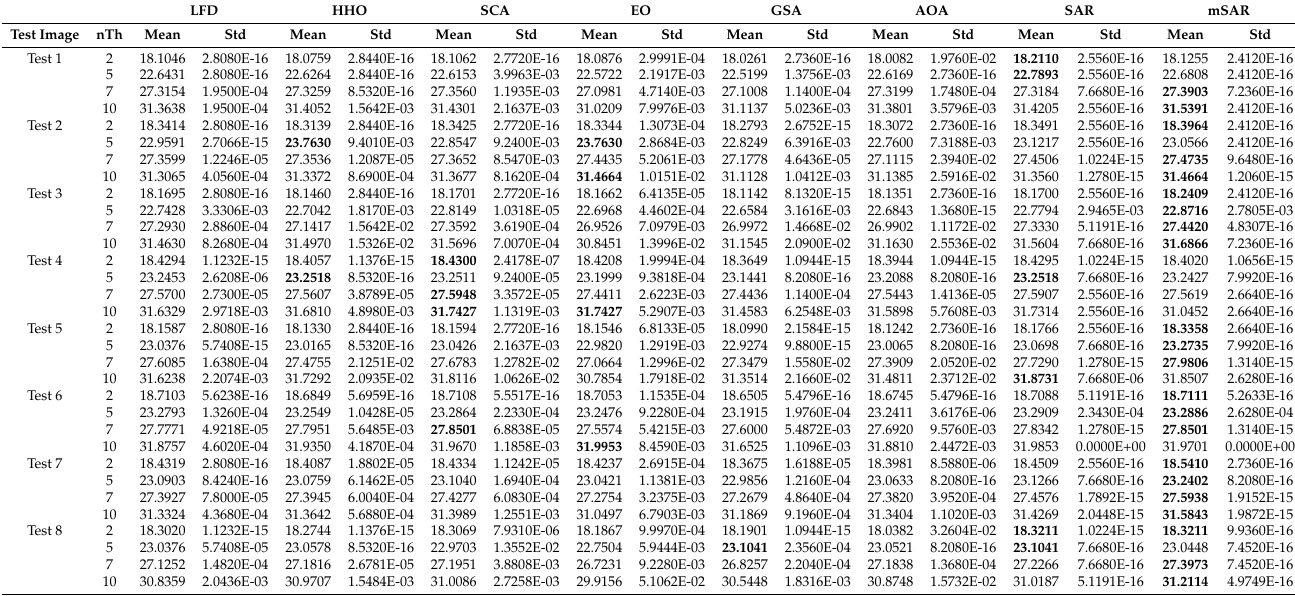
Table A3 of Appendix A illustrates the optimal thresholding values obtained by the mSAR algorithm and the original SAR algorithm using the Otsu method. Tables 8–11 illustrate the mean and STD outcomes of the fitness, PSNR, SSIM, and FSIM, respectively. Table 4. mSAR fuzzy entropy in terms of fitness values over all competed algorithms.